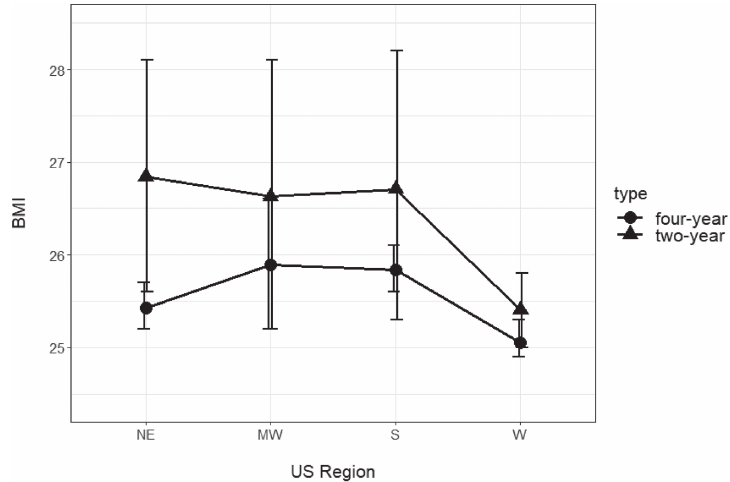
Fig. 1 Mean BMI of two-year versus four-year school students by US region. Note: Two-year school students self-report higher BMIs compared to four-year school students in all regions (p = 0.04). NE two-year n = 855 (overweight / obesity prevalence = 56.6%); NE four-year n = 78,296 (overweight / obesity prevalence = 32.7%); MW two-year n = 1,049 (overweight / obesity prevalence = 56.3%); MW four-year n = 76,516 (overweight / obesity prevalence = 38.5%); S two- year n = 769 (overweight / obesity prevalence = 28.5%); S four-year n = 88,481 (overweight / obesity prevalence = 38.2%); W two-year n = 16,962 (overweight / obesity prevalence = 45.9%); W four-year n = 142,059 (overweight / obesity prevalence = 37.5%)